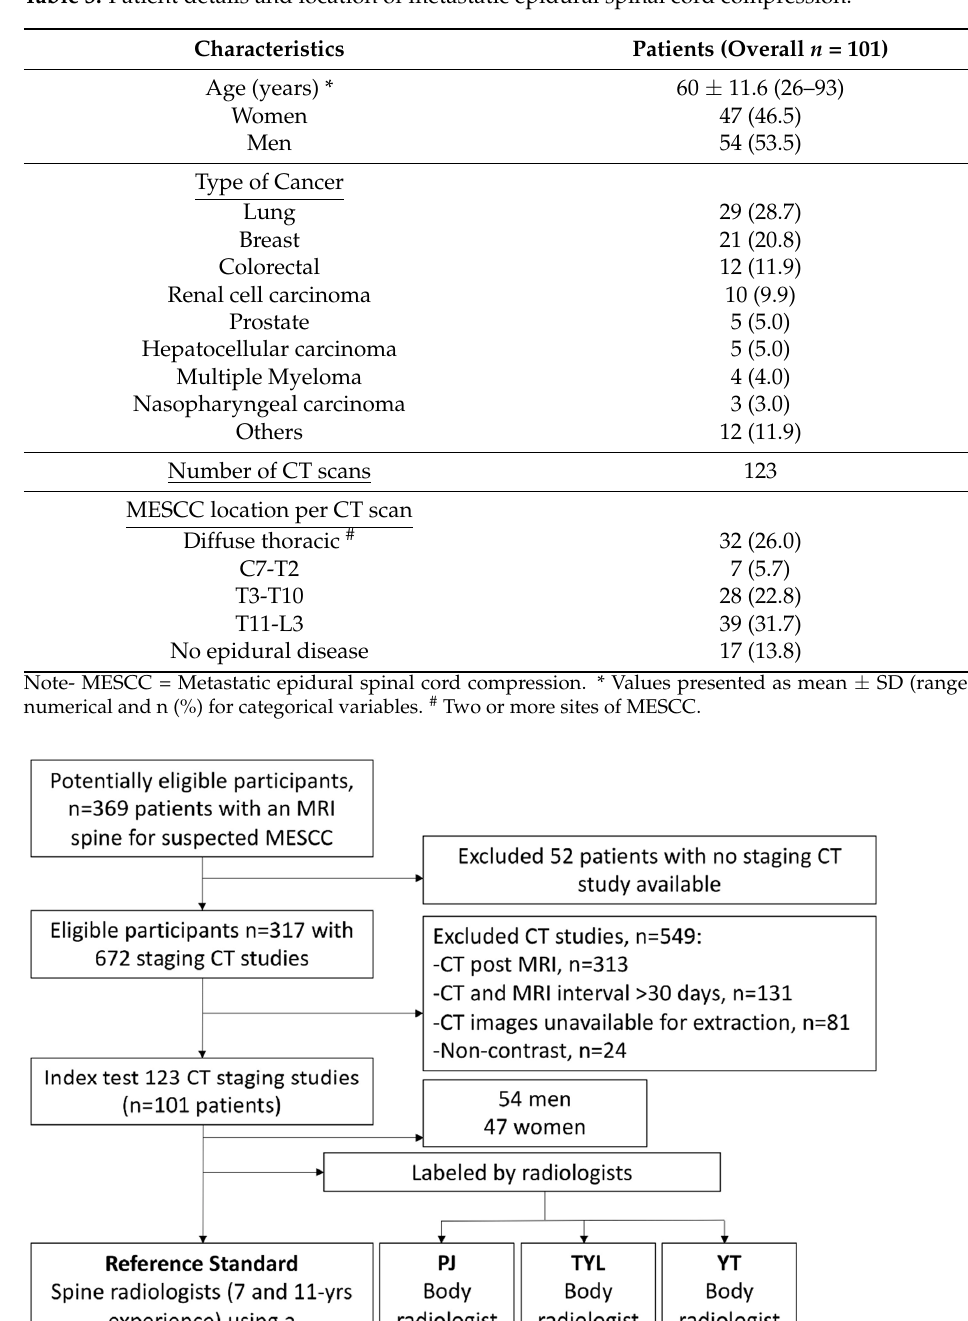
Table 3. Patient details and location of metastatic epidural spinal cord compression.